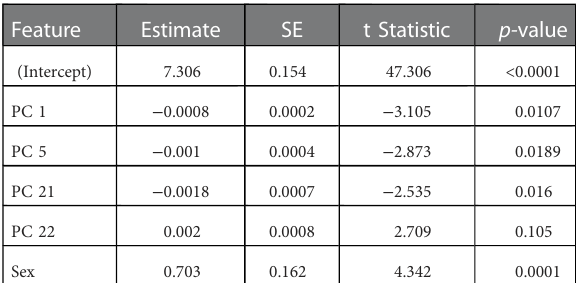
TABLE 3 Description of sEMG stepwise linear regression